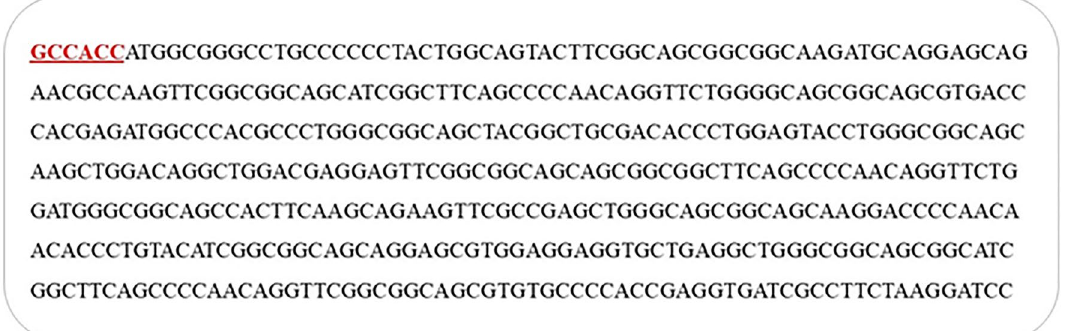
Figure 2. Reverse translation of multi epitope amino acid sequence into nucleotide sequence by using the J-CAT; Location of Kozak piece (red section). Vaxijen Antigen pro Probability of antigenicity Probable antigen